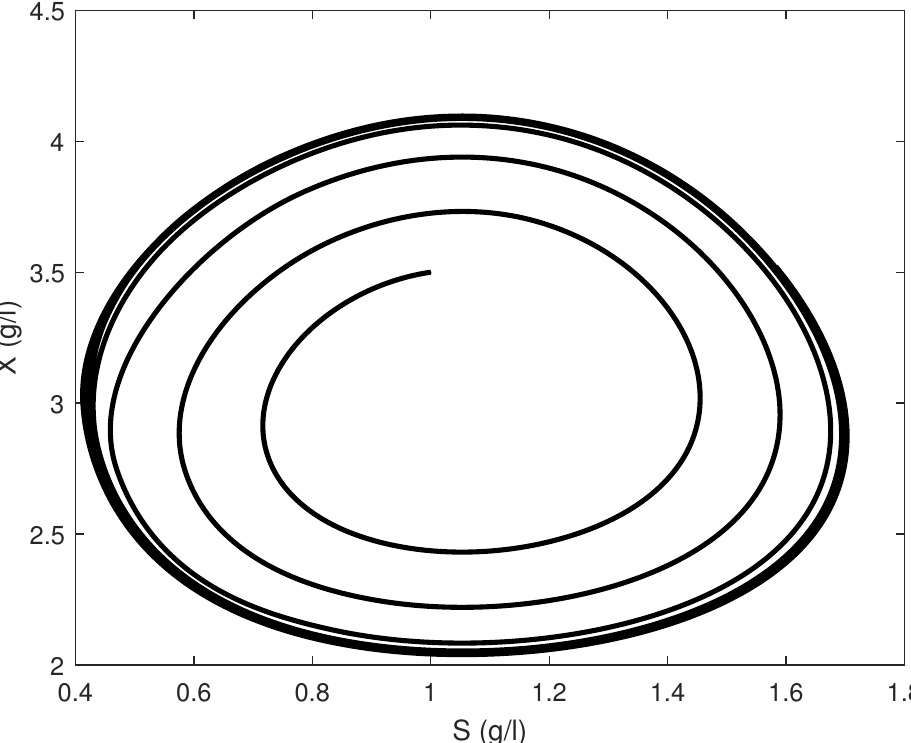
Figure 4. Example of limit cycle in the periodic region of Figure 3a for D = 0.01 [h − 1 ].